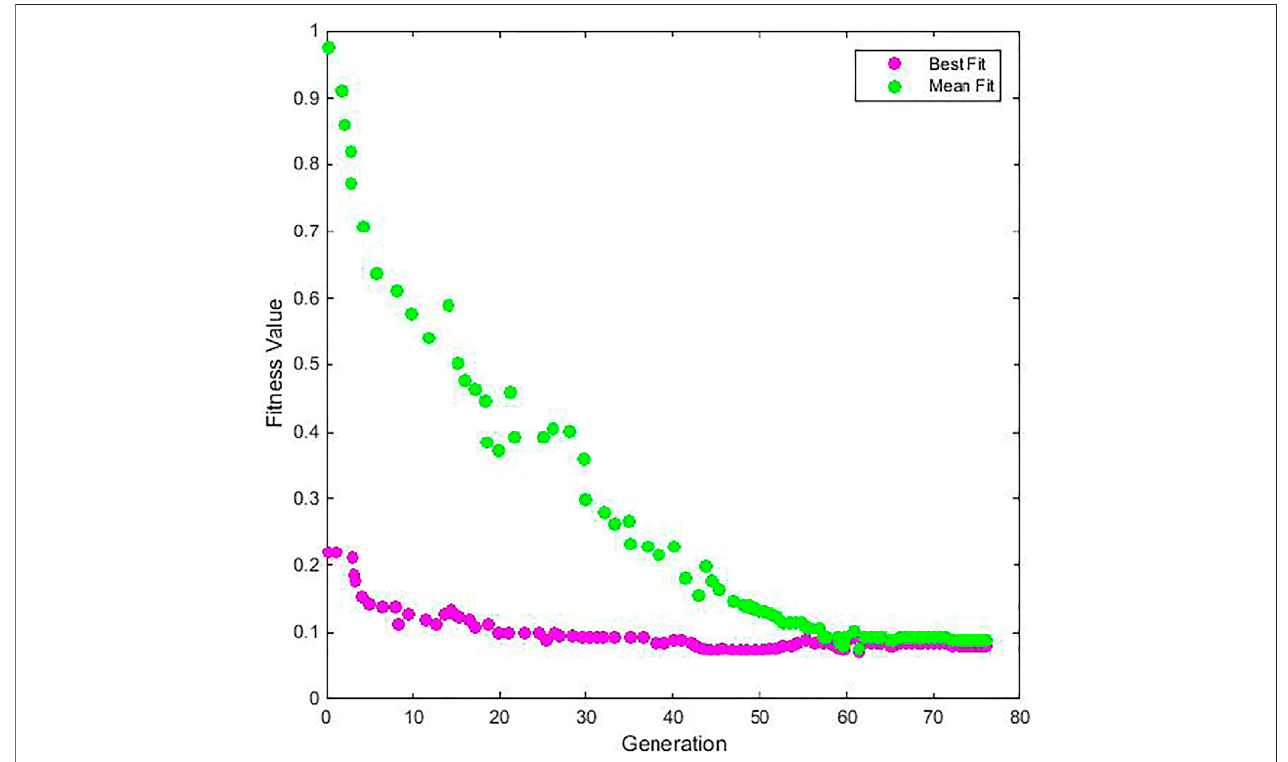
FIGURE 9 | Fitness value vs. generation numbers.